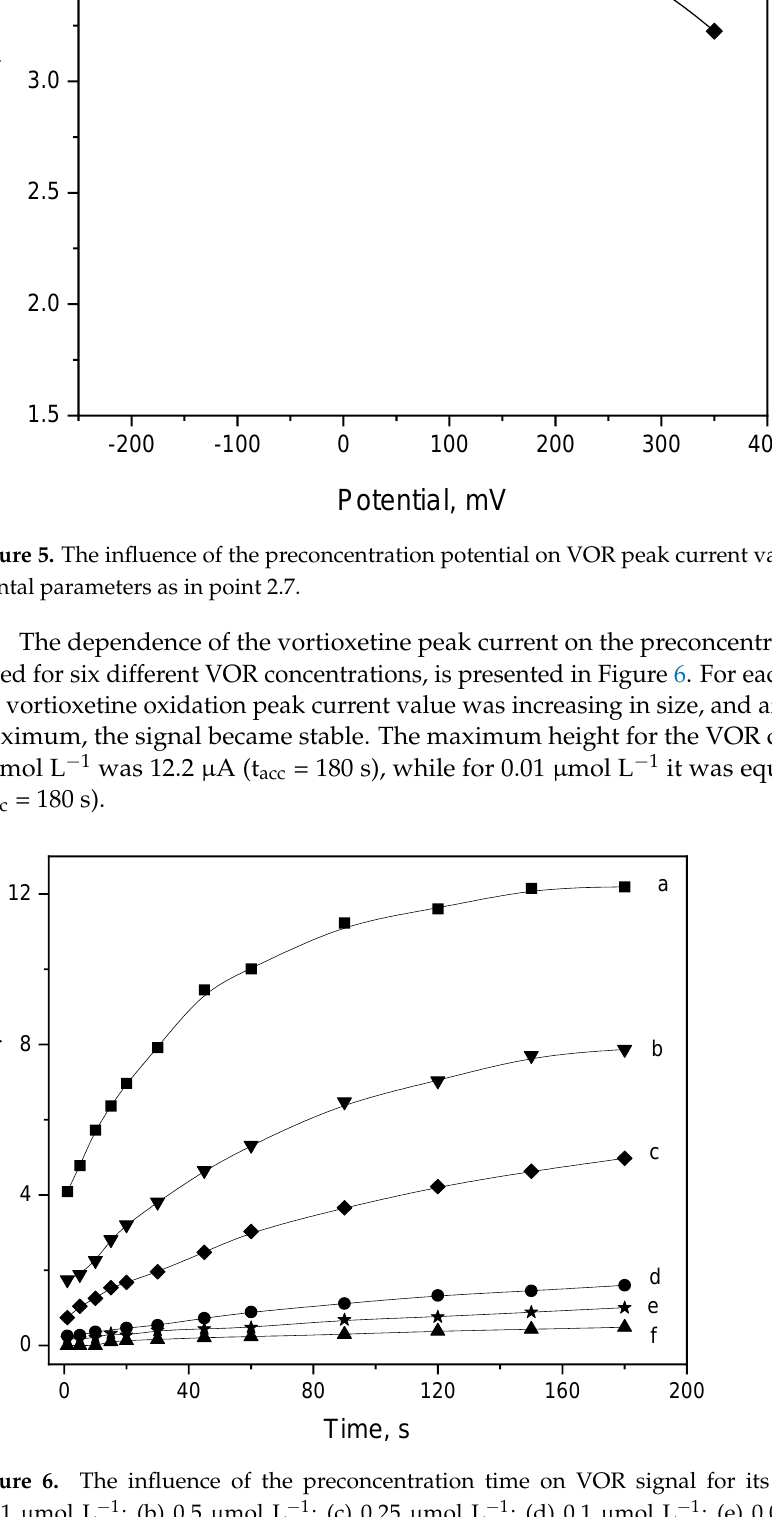
Figure 6. The influence of the preconcentration time on VOR signal for its concentration of (a) 1 µmol L −1 ; (b) 0.5 µmol L −1 ; (c) 0.25 µmol L −1 ; (d) 0.1 µmol L −1 ; (e) 0.05 µmol L −1 and (f) 0.01 µmol L −1 . Other instrumental parameters as in point